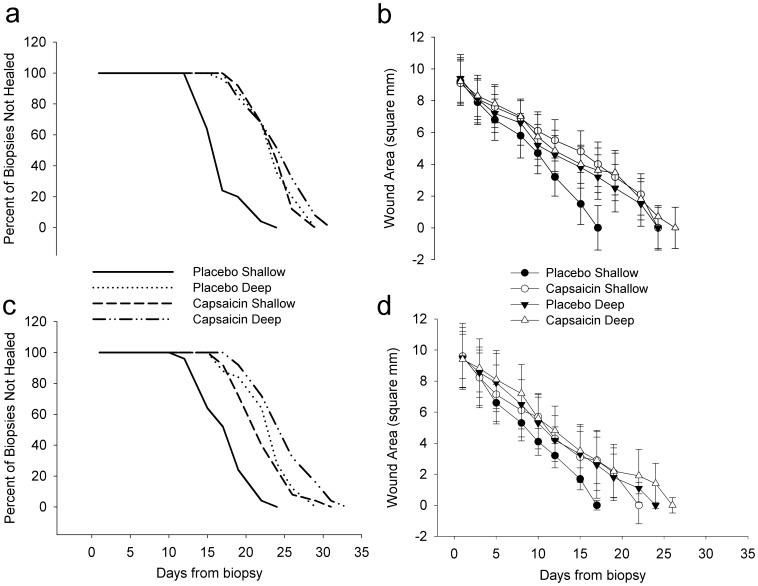
Rates of shallow and deep wound healing from capsaicin and placebo treated skin.Wound healing from day 1 (a & b) and day 14 (c & d) biopsies. Survival curves (a & c) are defined as the time from biopsy to wound closure (percent of biopsies not healed). The area of the open wound at each time point by biopsy type and treatment is shown for day 1 (b) and day 14 (d). Shallow biopsies from capsaicin treated areas healed more slowly than shallow biopsies from placebo treated areas (P<0.001 vs. placebo) on day 1 and day 14. There were no differences in capsaicin and placebo treated deep biopsies (P = 0.43 vs. placebo, day 1; P = 0.09 vs. placebo day 14). Shallow biopsies from capsaicin treated areas healed more quickly on day 14 (d) than on day 1 (b) (P = 0.03). Statistical significance is not displayed in these graphs.